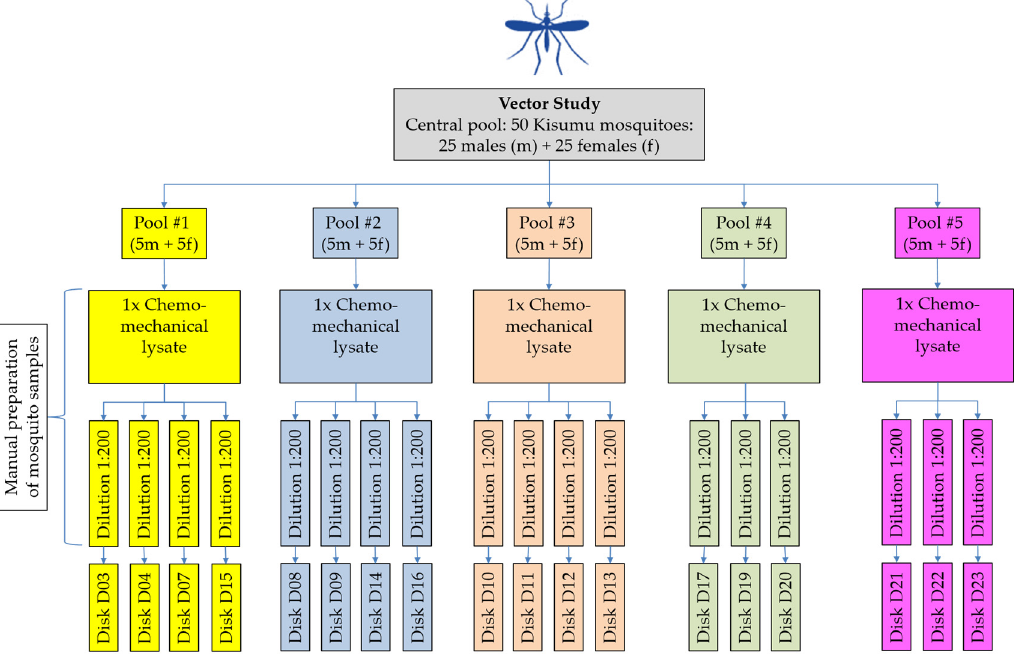
Figure 1. Schematic workflow for manual preparation of mosquito samples prior to VectorDisk tests during the Vector Study.